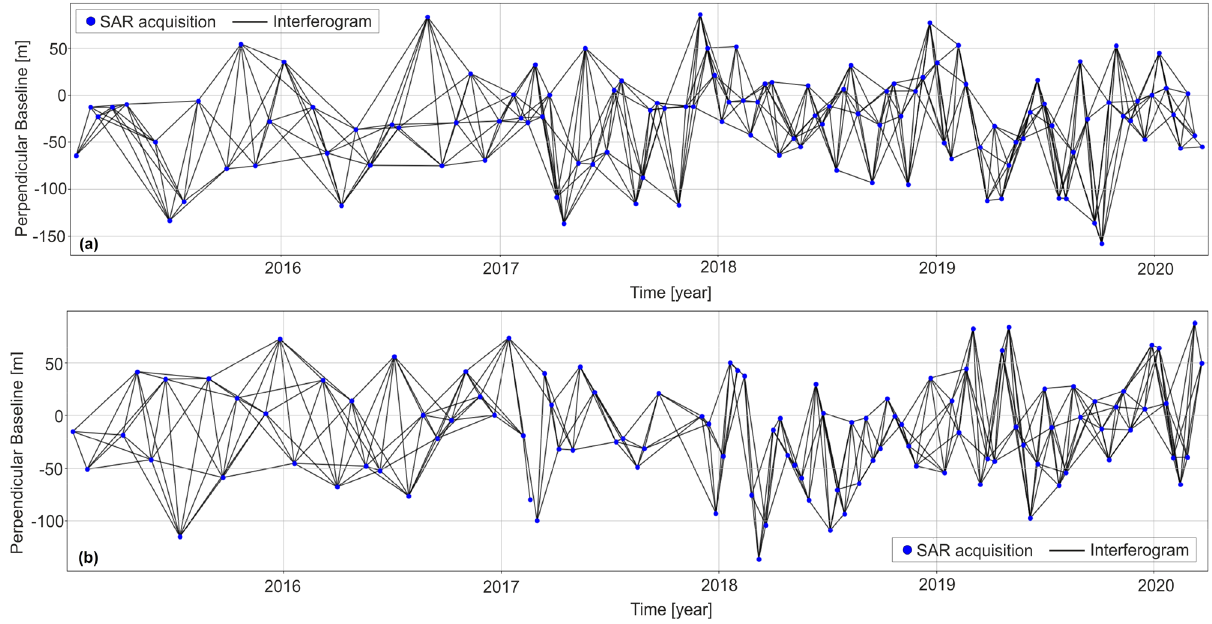
Figure 4. The perpendicular and temporal baseline network for the ( a ) ascending and ( b ) descending